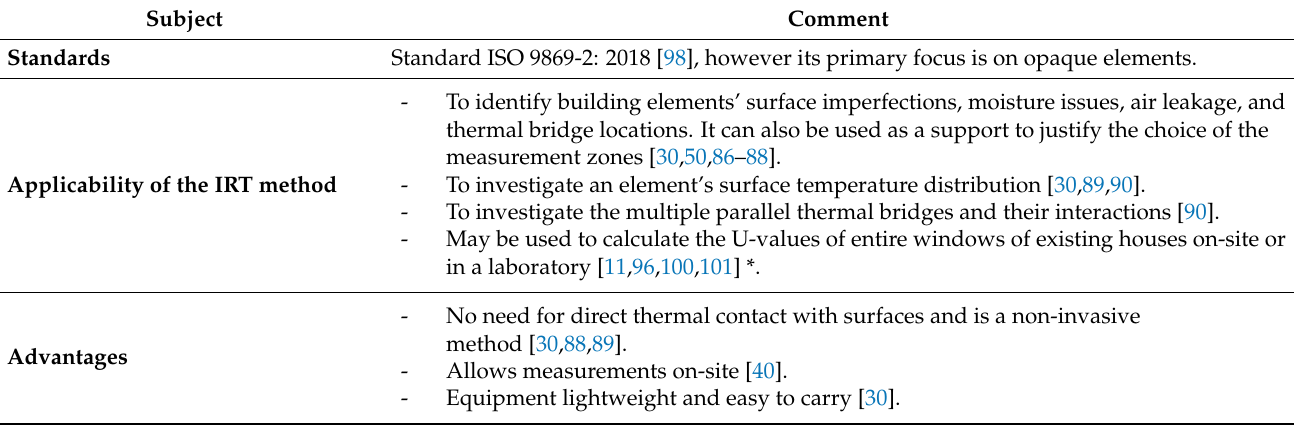
Table 4. Summary of the IRT method with a focus on glazing